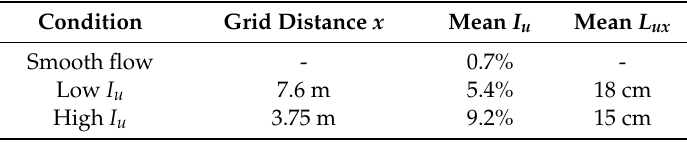
Table 1. Tests conditions reproduced during